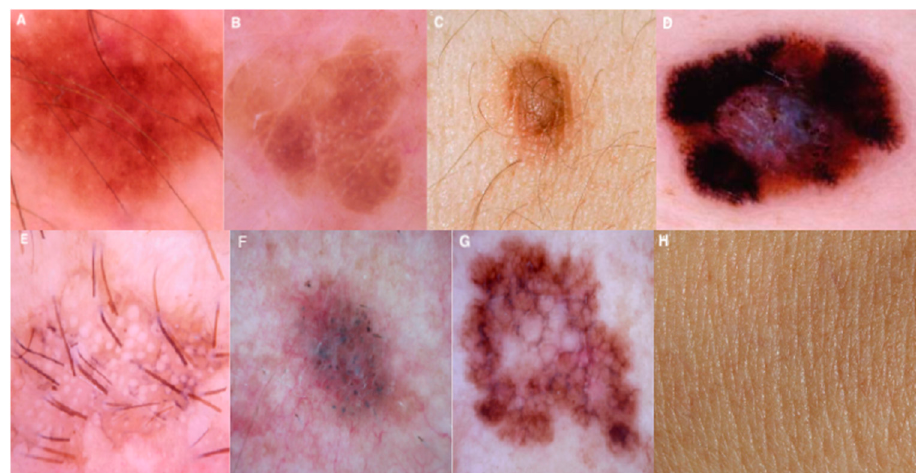
Figure 4. Images of various image classes from HAM10000 dataset. The image of various diseases are as follows ( A ) Melanocytic Nevi, ( B ) Benign Keratosis-like Lesions, ( C ) Dermatofibroma, ( D ) Vascular Lesions, ( E ) Actinic Keratoses and Intraepithelial Carcinoma, ( F ) Basal Cell Carcinoma, ( G ) Melanoma, and ( H ) Normal skin image are presented.